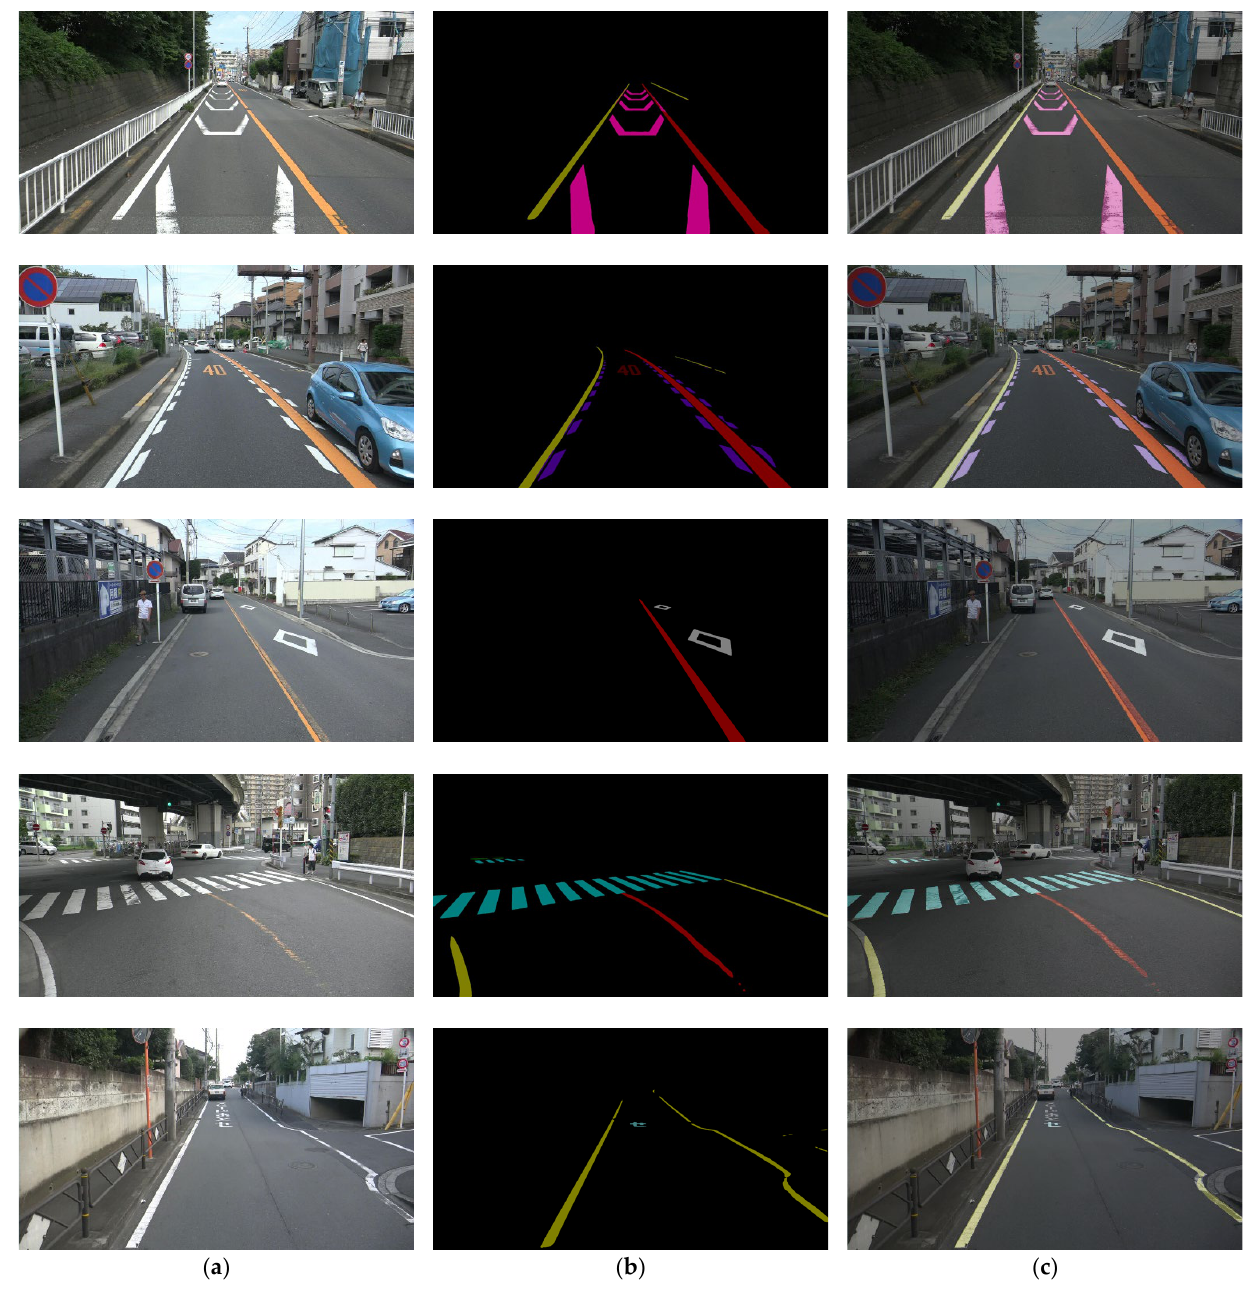
: ( a ) original 𝑠𝑠𝑠𝑠𝑠𝑠𝑠𝑠𝑠𝑠𝑠𝑠 = {0.5,1.0,2.0}